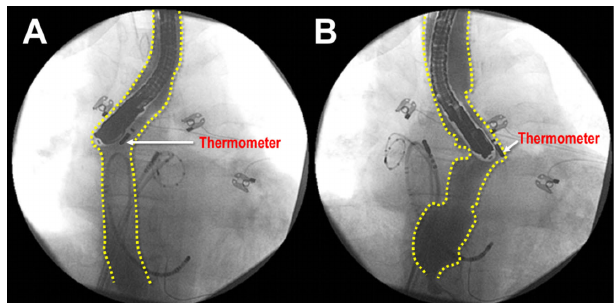
Fig. 3 - Barium esophagography showing esophageal displacement during RF catheter ablation of AF. In A, the thermometer position is satisfactory; however, in B, the thermometer is misplaced and should not be considered for temperature control of the ablation. The yellow dotted lines show the esophageal lumen contour. Enough bilateral esophageal displacement can also be observed, allowing safe ablation. AF=atrial fibrilation;